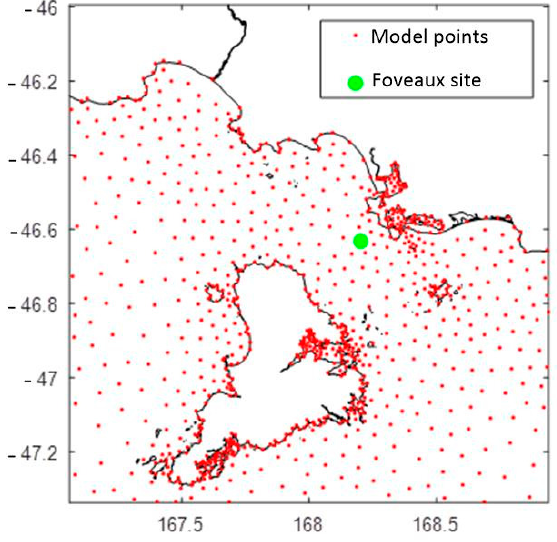
Figure 3. Tidal current model points near Stewart Island from NIWA.